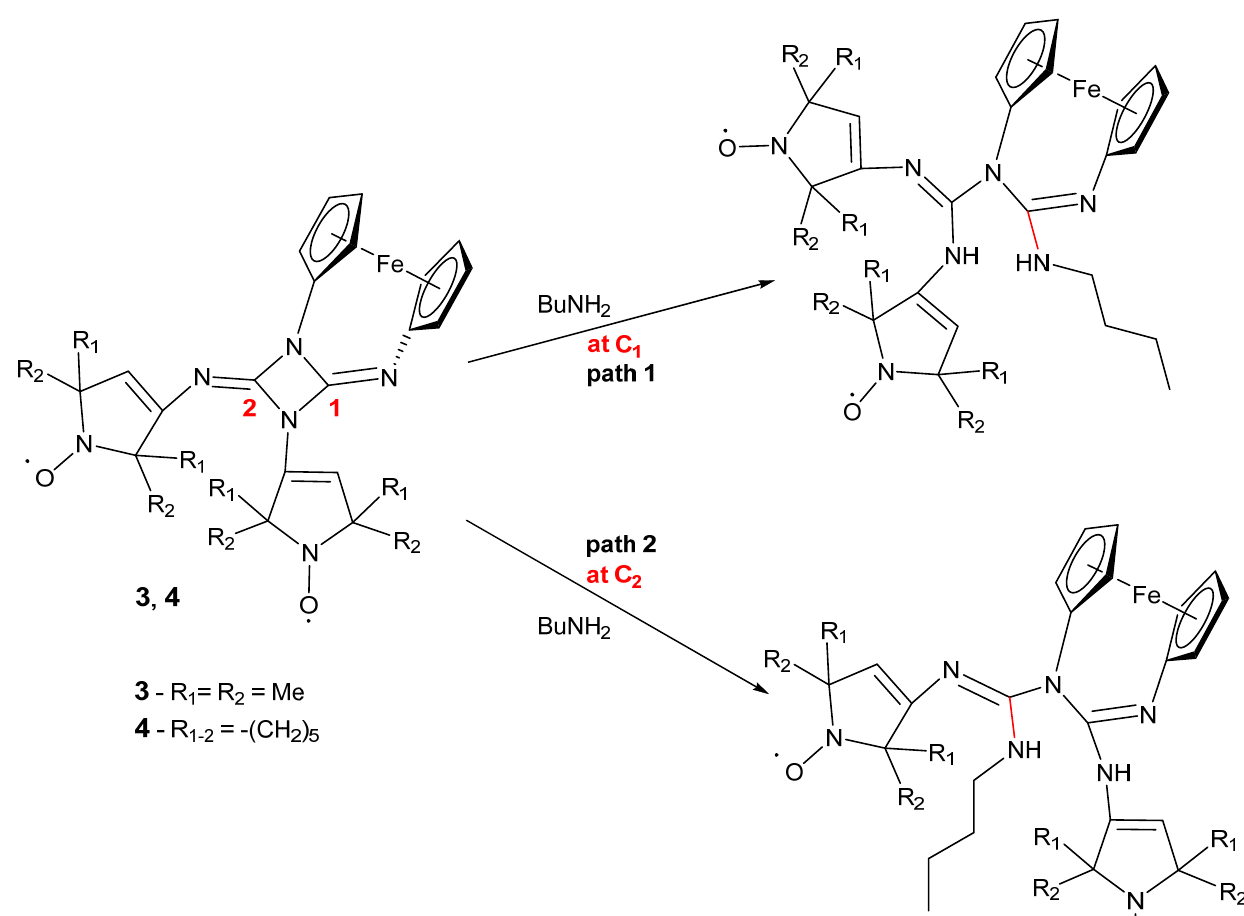
Figure 10. Proposed schemes for the reaction of biradicals with an excess of n-butylamine at room temperature.